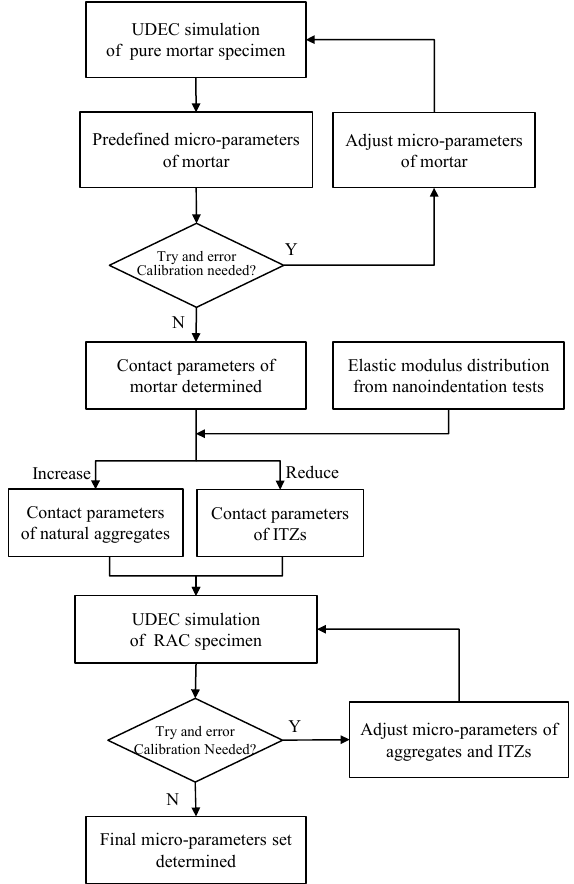
Figure 8. Micro-parameters determination procedure for MRAC simulation.